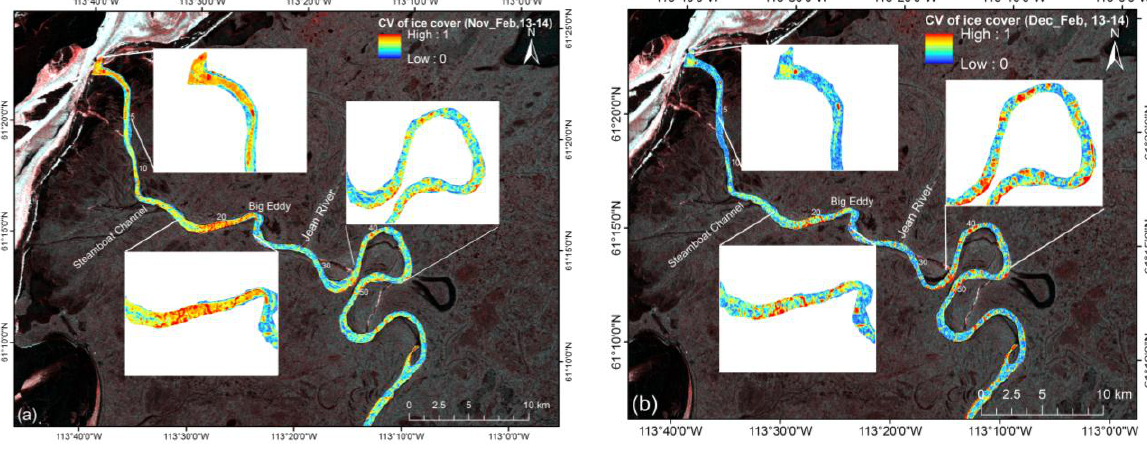
Figure 7. Intra-annual variation of ice covers along the Slave River Delta channel during the 2013–2014 winter, from November to February ( a ) and from December to February ( b ). The number along the river (e.g., 5, 10, etc. ) indicates the kilometer distance from the river mouth at Great Slave Lake. (RADARSAT-2 Data and Products © MacDonald, Dettwiler and Associates Ltd. (2013–2014)—All Rights Reserved. RADARSAT is an official trademark of the Canadian Space